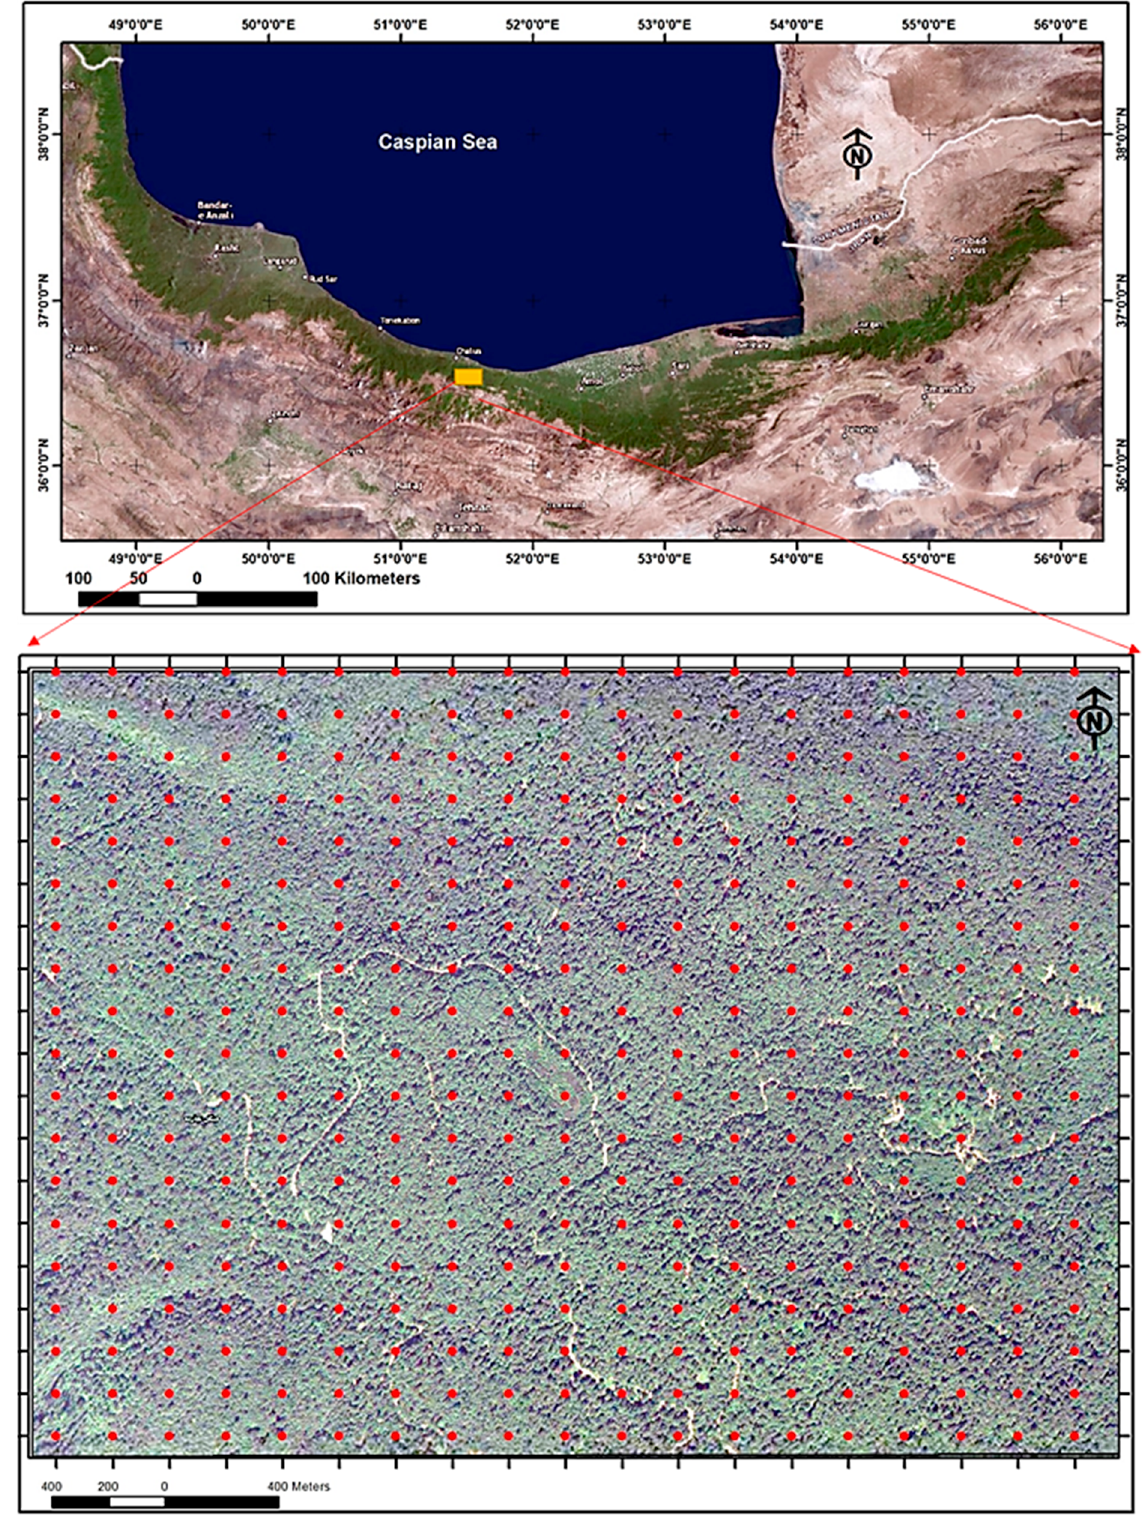
Figure 1. The location of study area in northern Iran represents the broader boundary of the study area; the network of permanent sample plots are in the form of red dots.